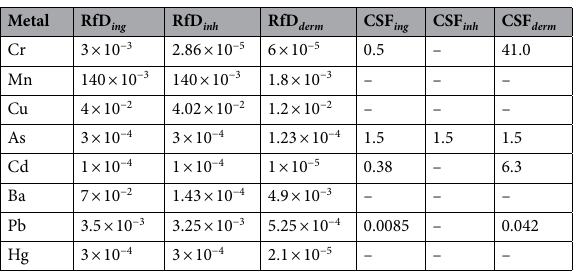
Table 2. RfD and CSF values used in this study 39,42